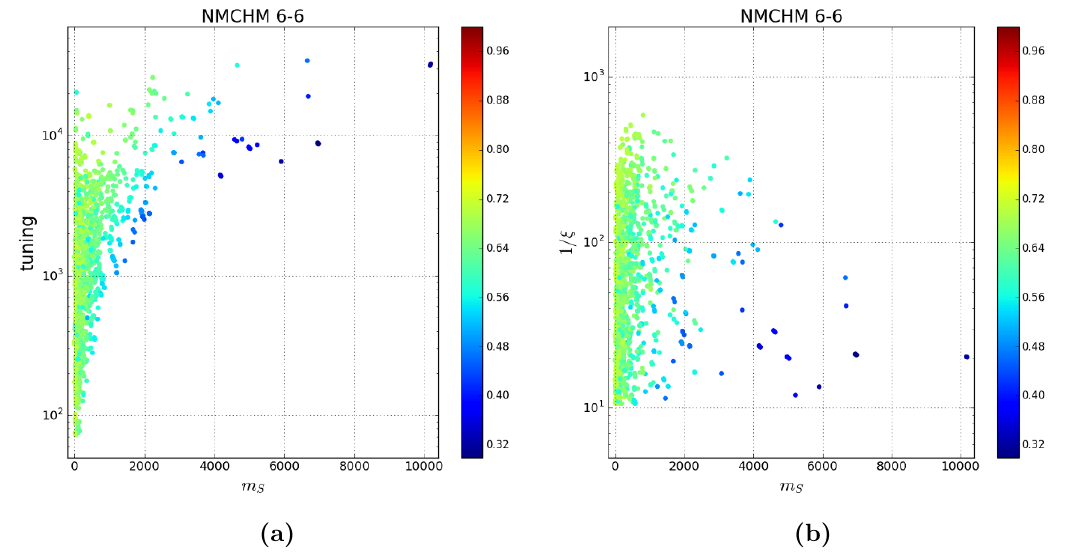
Figure 15. The singlet mass (in GeV) vs (a) higher order tuning and (b) naive tuning with sin (cid:18) as the third dimension, for points with (cid:18) 2 f 0 ; (cid:25)= 4 g